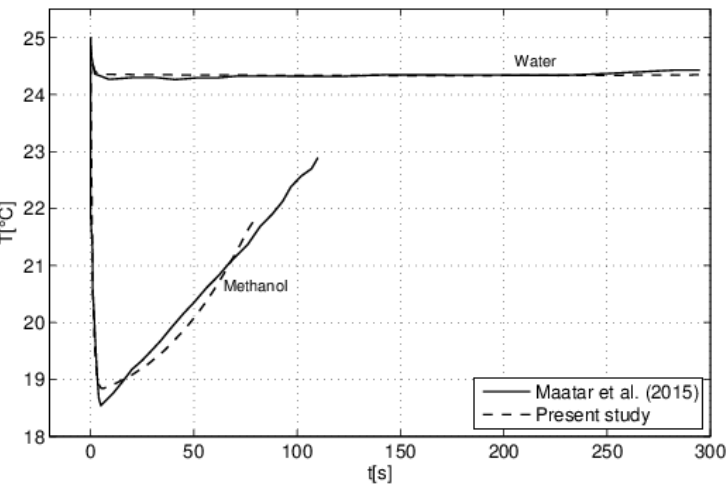
Figure 6. Time evolution of the apex temperature: comparison with the numerical study of [22]. (V 0 = 3.64 mm 3 , θ = 57.2°, T 0 = 25 °C, H = 40%).